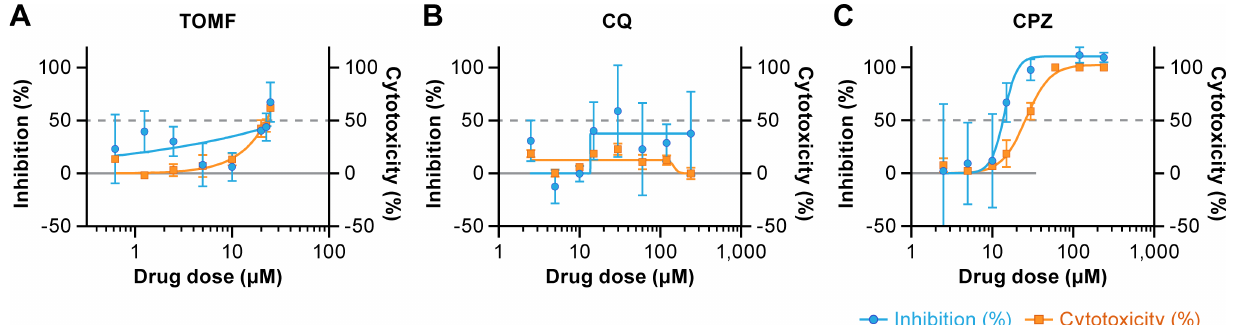
Fig 4. Antiviral activity of three compounds on MERS-CoV infection in MDMs. (A) Effect of pretreatment of monocyte-derived macrophages (MDMs) with toremifene (TOMF), (B) chloroquine (CQ), and (C) chlorpromazine (CPZ) prior to MERS-CoV exposure on subsequent infection. The effect of these compounds on the cytotoxicity of macrophages without virus was also studied. MERS-CoV S protein was detected in infected cells using an immunofluorescence assay. The antigen was detected with a rabbit polyclonal antibody to S protein followed by staining with Alexa Fluor 594-conjugated goat anti-rabbit antibody. Percent inhibition of MERS-CoV infection is shown in blue, and percent cytotoxicity of the compounds without virus is shown in orange. Dotted gray line indicates half maximal effective concentrations (EC 50 ) and 50% cytotoxicity concentrations (CC 50 ). The selectivity index (SI) is defined as CC 50 (cid:4) EC 50 . Results are representative of 2 individual experiments with 3 replicates in each experiment (means ± standard error of the means [SEM]).